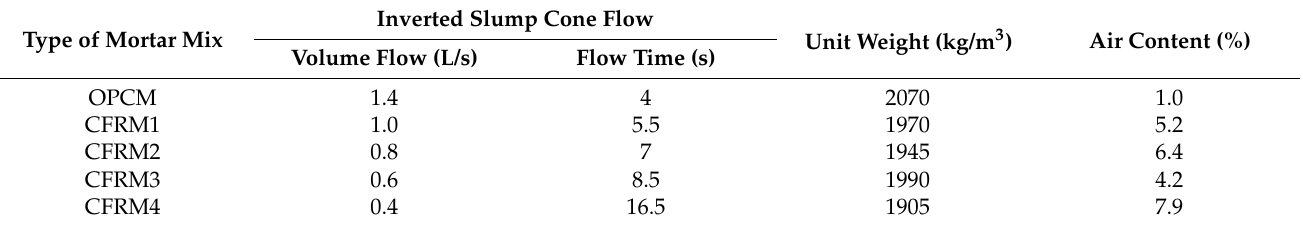
Table 3. Properties of the different freshly mixed mortar